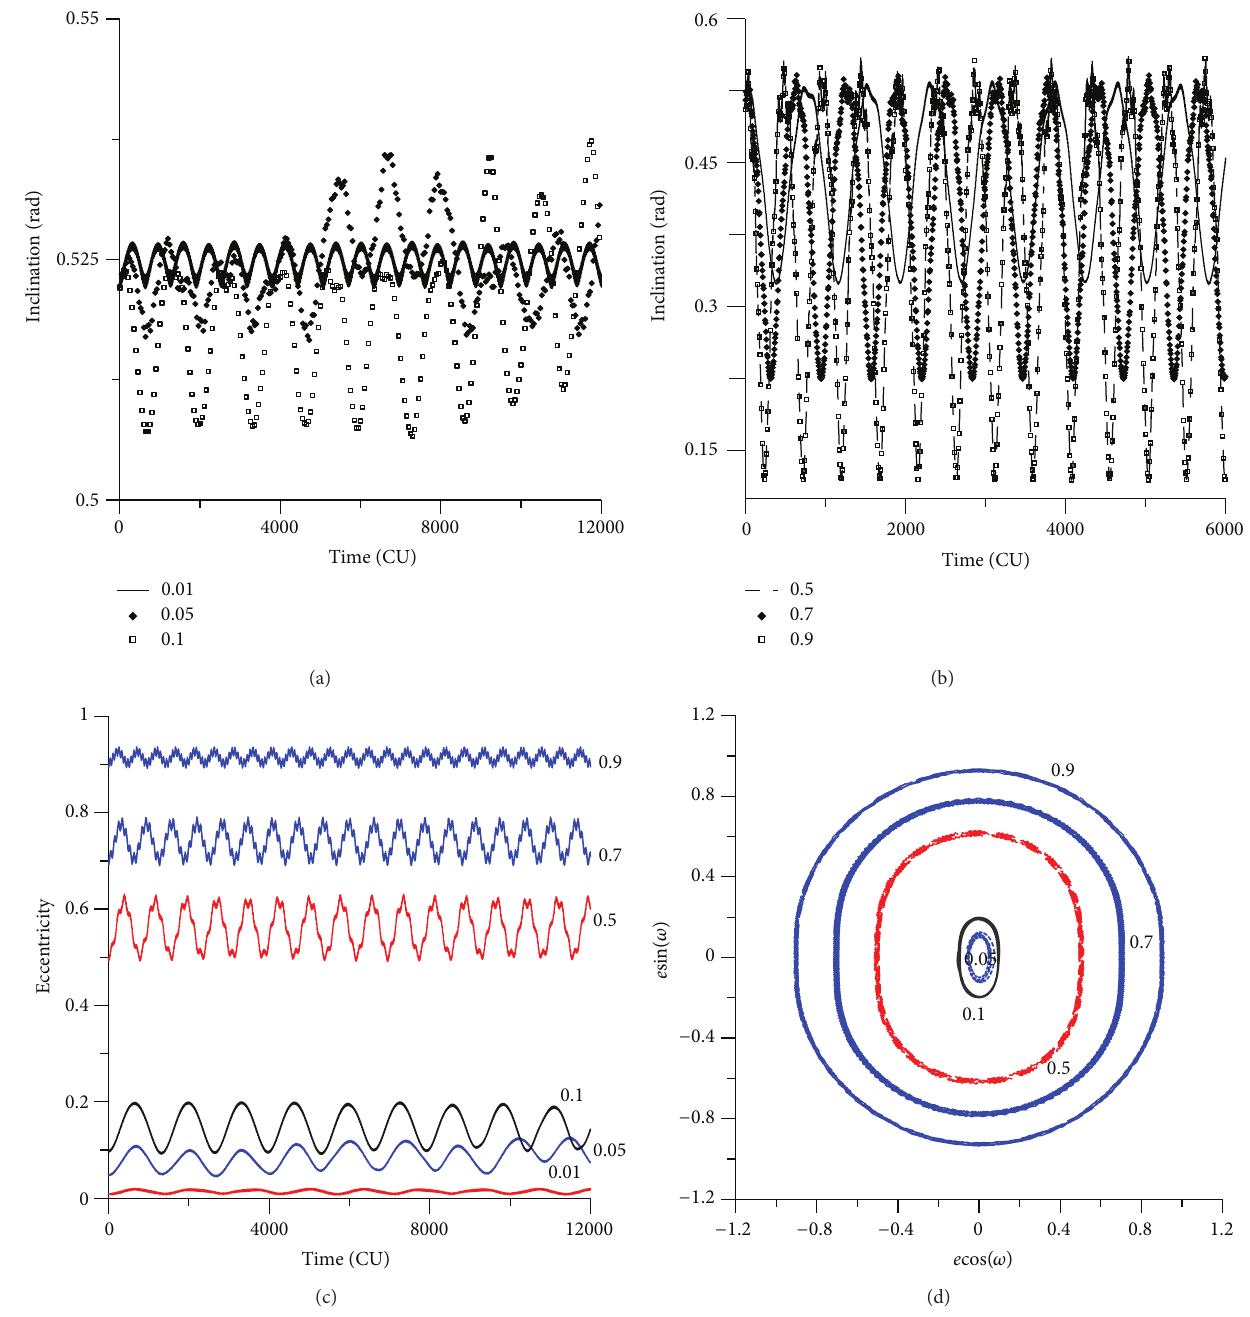
Figure 12: Behavior of orbital elements for initial inclination of 30 degrees. The values of the eccentricity are 0.01, 0.05, 0.10, 0.50, 0.70, and 0.90. The initial conditions are a = 0.341 canonical units, M 0 (0) = 0, 𝜔 (0) = 0, and Ω (0) =